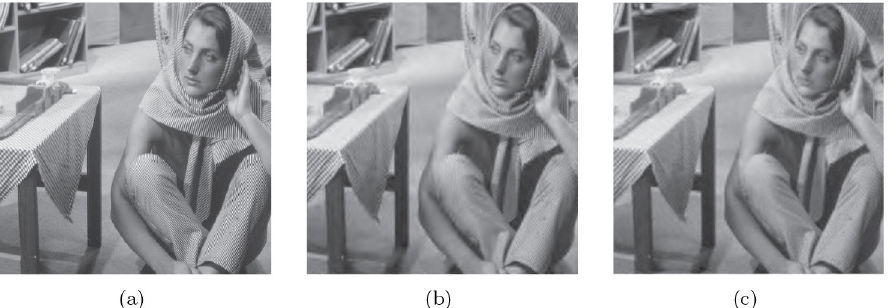
Fig 10. Improved contourlet-based SPIHT and contourlet-based SPIHT perfomance. (a) shows the original image. (b) shows the method in [9], which adopts the contourlet that replaces the LP decomposition with wavelet. (c) shows the image coded with an contourlet based SPIHT. From the images, it can be observed that textures in (b) are more clear than the textures in (c) Reprinted from [40] under a CC BY license, with permission from IEEE publisher, original copyright 2019.